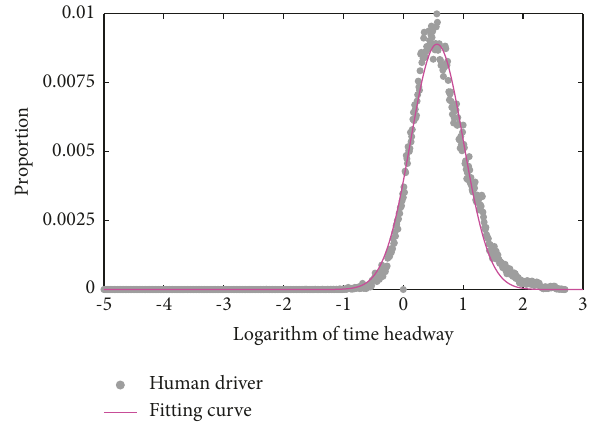
Figure 6: The fitting curve of the distribution of the logarithm of time